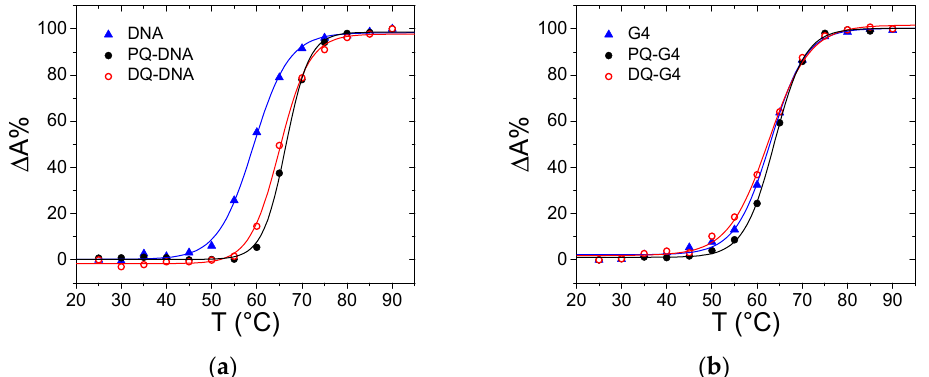
Figure 5. Melting curves for ( a ) ct-DNA (triangle), PQ/DNA (full circle) and DQ/DNA (open circle), C DNA = 1.14 × 10 − 5 M, C PQ = 1.14 × 10 − 5 M, C DQ = 1.06 × 10 − 5 M, NaCac 2.5 mM, pH 7.0, 260 nm; ( b ) G-quadruplex tel23 (G4, triangle), PQ/G4 (full circle) and DQG4 (open circle), C G4 = 5.51 × 10 − 6 M, C PQ = 6.01 × 10 − 6 M, C DQ = 5.47 × 10 − 6 M, KCl 0.1 M, LiCac 2.5 mM, pH 7.0, 295 nm.